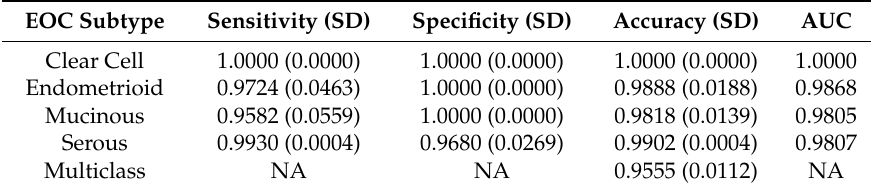
Table 2. Accuracies of the binary and multiclass classification and prediction by machine